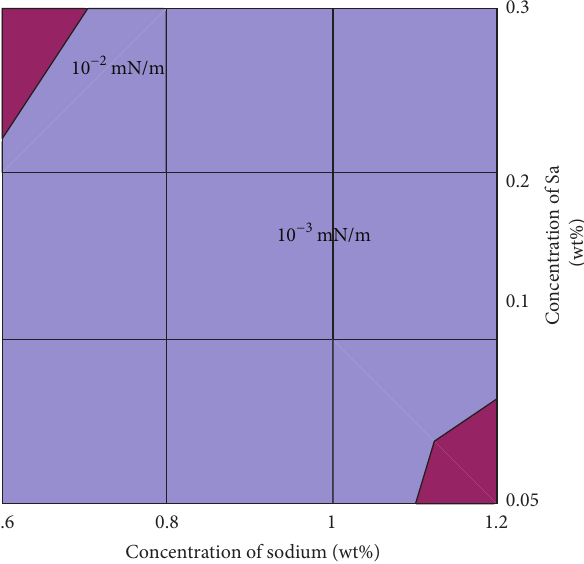
Figure 10: Interfacial tension of the HAPAM ASP system (in on-site injection